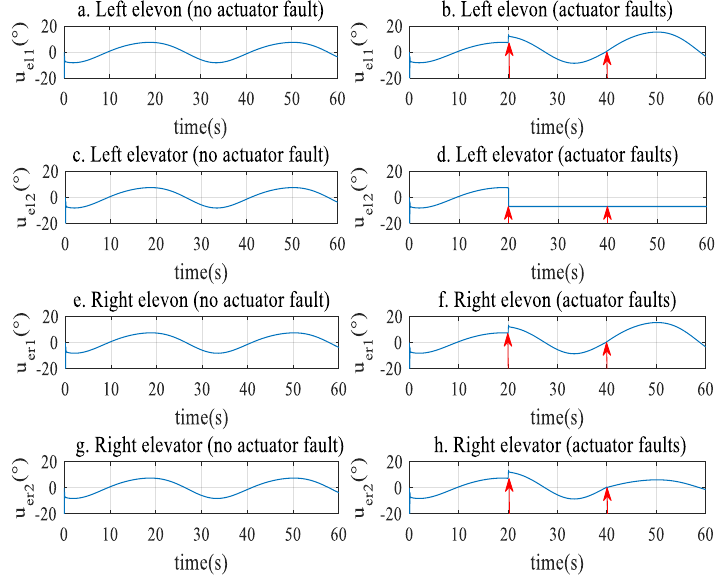
Figure 12. Tracking response of p , q and r .